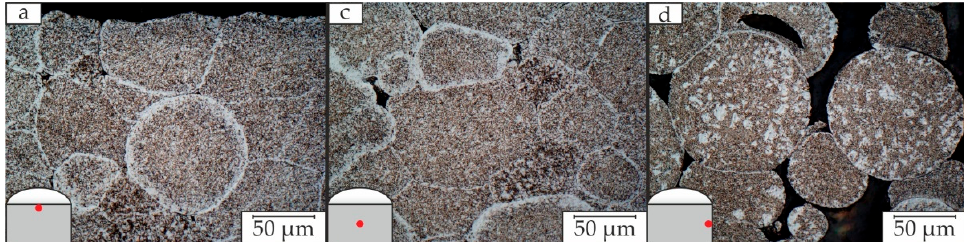
Figure 13. Microstructure in defined positions a, c and d according to Figure 1 (right) of a TNM sample sintered at 1200 °C, with 2 min dwell time and 30 MPa pressure.